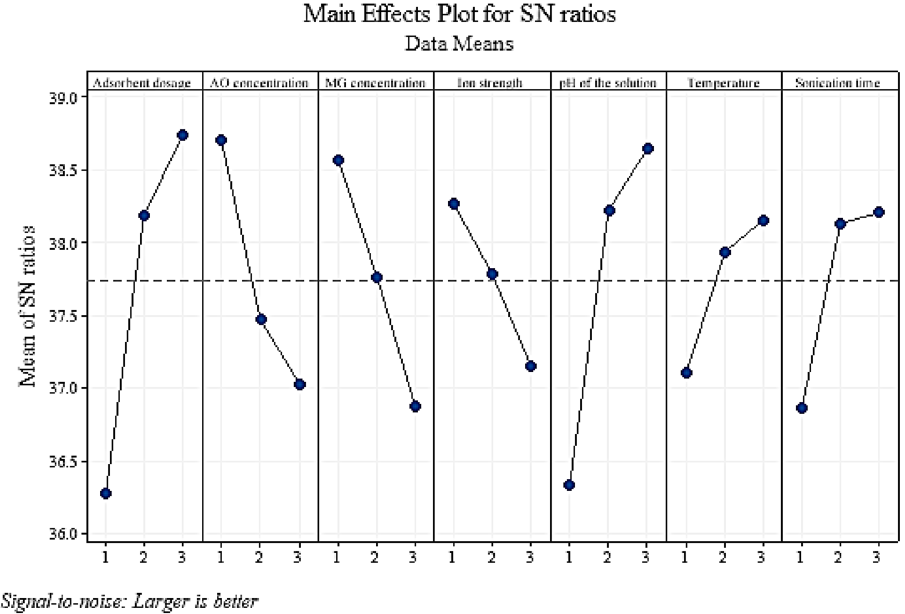
Figure 3. Signal to noise ratios for removal MG and